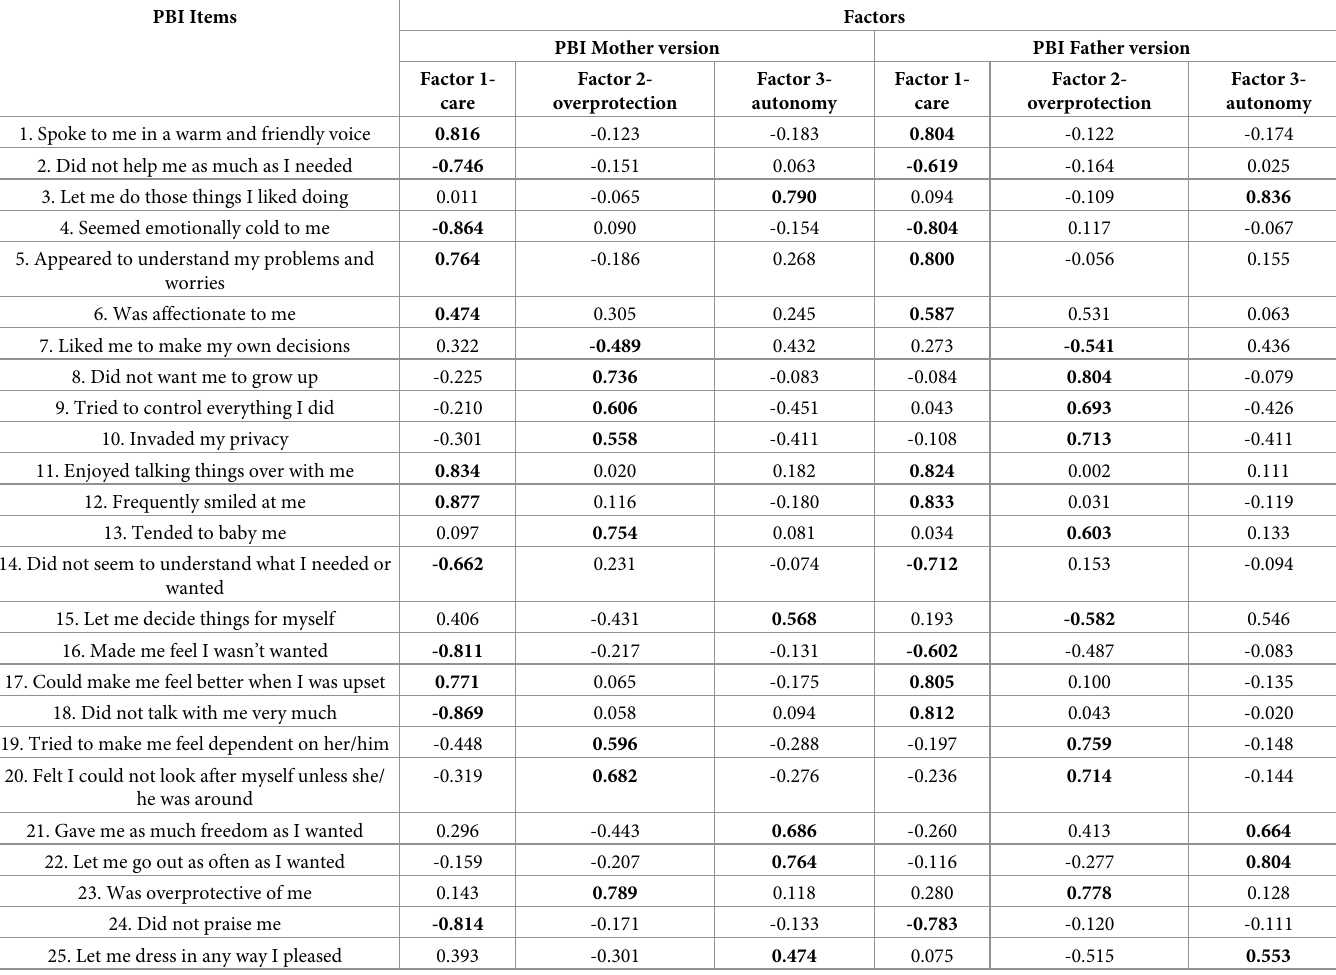
Table 1. Factor loadings of the Polish version of the Parental Bonding Instrument–results of exploratory factor analysis in a group of adults (n = 473). PBI Items